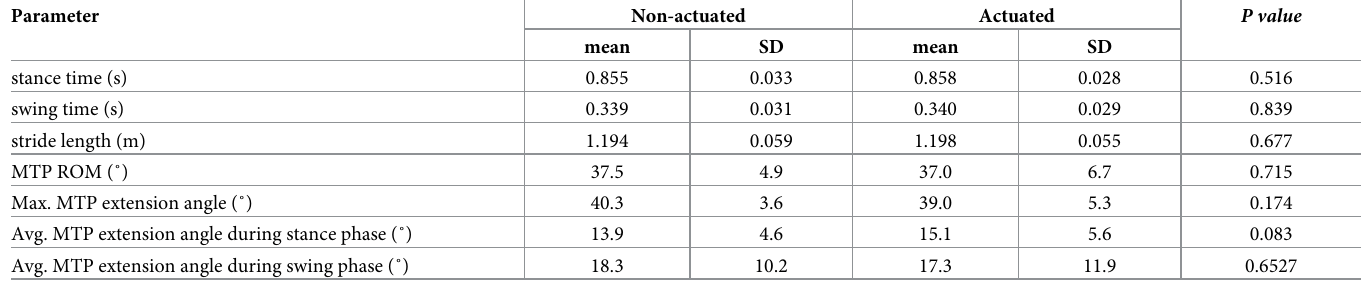
Table 2. Means, standard deviation (SD) and statistical results for spatiotemporal and kinematics parameters during walking with the MTP assistive device under actuated and non-actuated conditions. Parameter